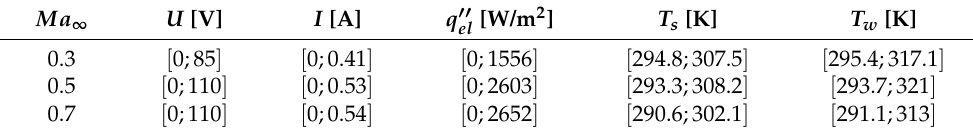
Table 3. Min./max. thermal conditions for the individual inflow